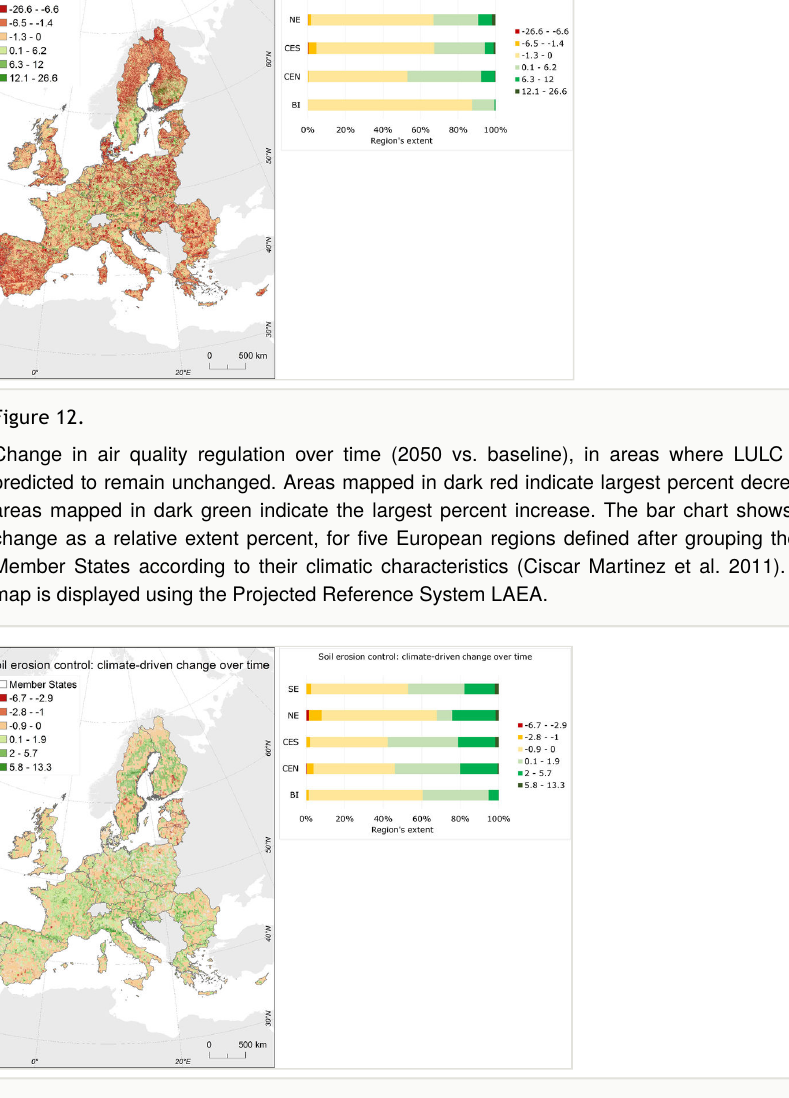
Change in soil erosion control over time (2050 vs. baseline), in areas where LULC was predicted to remain the same. Areas mapped in dark red indicate largest percent decrease, areas mapped in dark green indicate the largest percent increase. The bar chart shows the change as a relative extent percent, for fi ve European regions de fi ned after grouping the 28 Member States according to their climatic characteristics (Ciscar Martinez et al. 2011). The map is displayed using the Projected Reference System